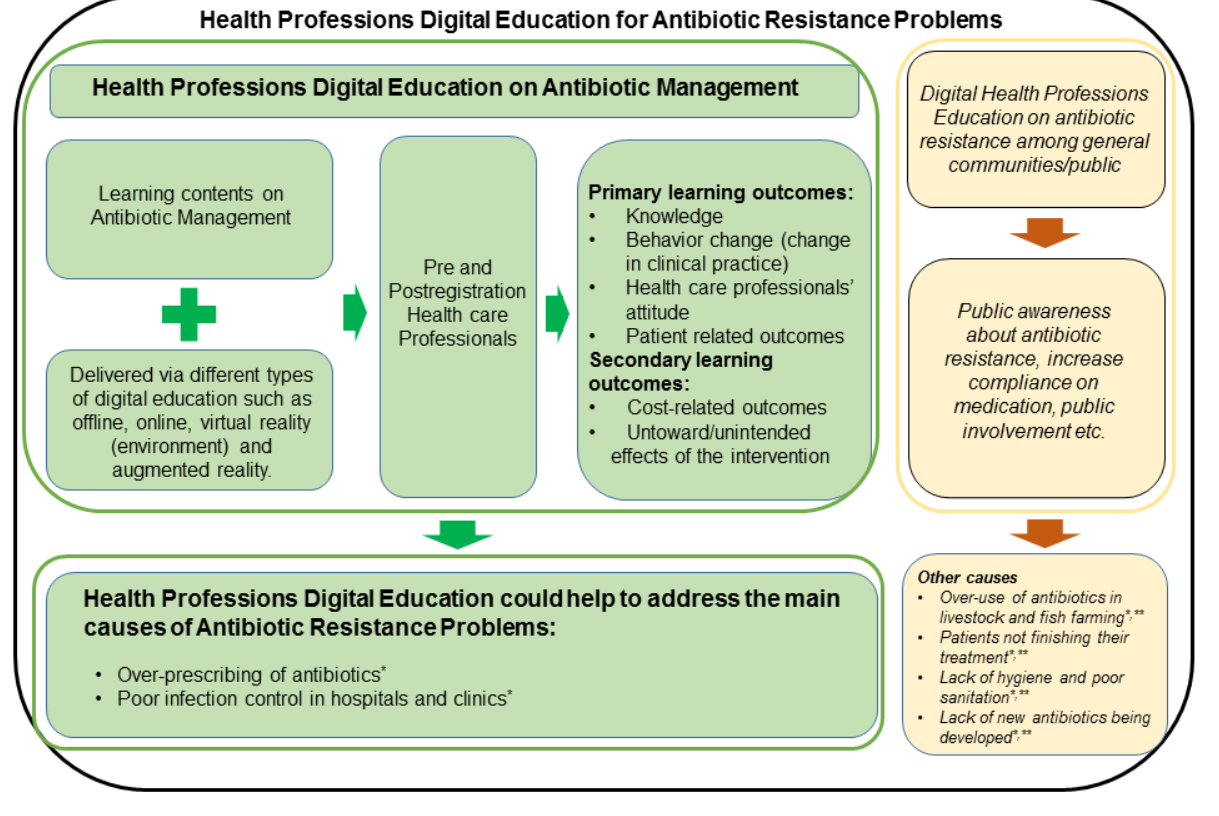
Figure 1. A simplified conceptual framework to address antibiotic resistance by empowering health professions education through digital